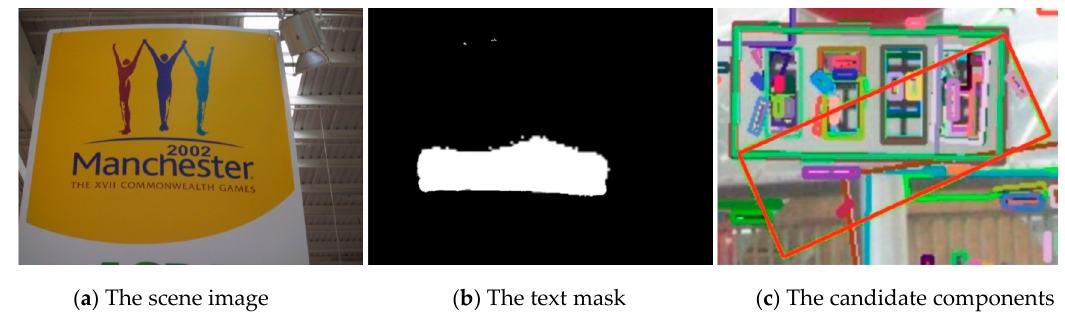
Figure 1. An example of dense scene text detection. ( a ) The input image, ( b ) the text mask obtained by a segmentation model, which produces spurious text instances. ( c ) The candidate components in the bottom-up mechanism—e.g., these components generated by the Maximally Stable Extremal Regions (MSERs) algorithm. There is a component covering part of the text regions and surrounding background simultaneously (shown in red box), which it has been difficult to deal with in post-processing in the previous works.